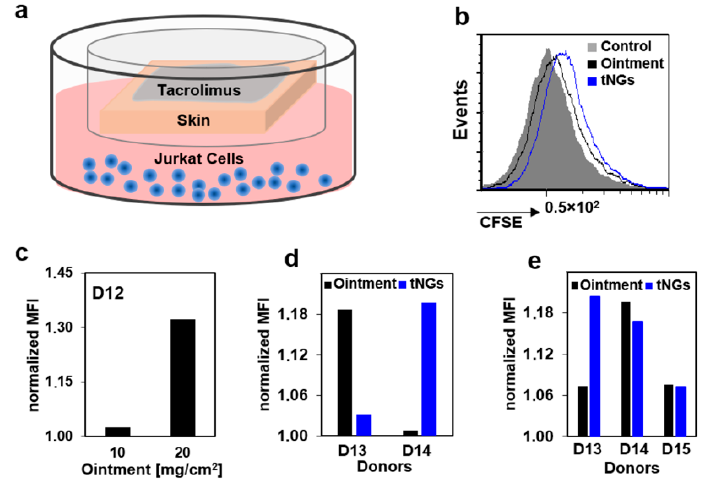
Figure 5. Penetration of tacrolimus across full thickness skin and inhibition of Jurkat cell proliferation. ( a ) Typical experimental procedure. Tacrolimus ointment or nanogels were applied topically on ex vivo skin with disrupted barrier (tape stripping 50 times) that was co-cultured with CFSE-labelled Jurkat cells in a trans-well set up. ( b ) Flow cytometry histogram of cells after treatment with 20 mg / cm 2 of ointment. ( d , e ) Normalized mean fluorescence intensity of Jurkat cells co-cultured for